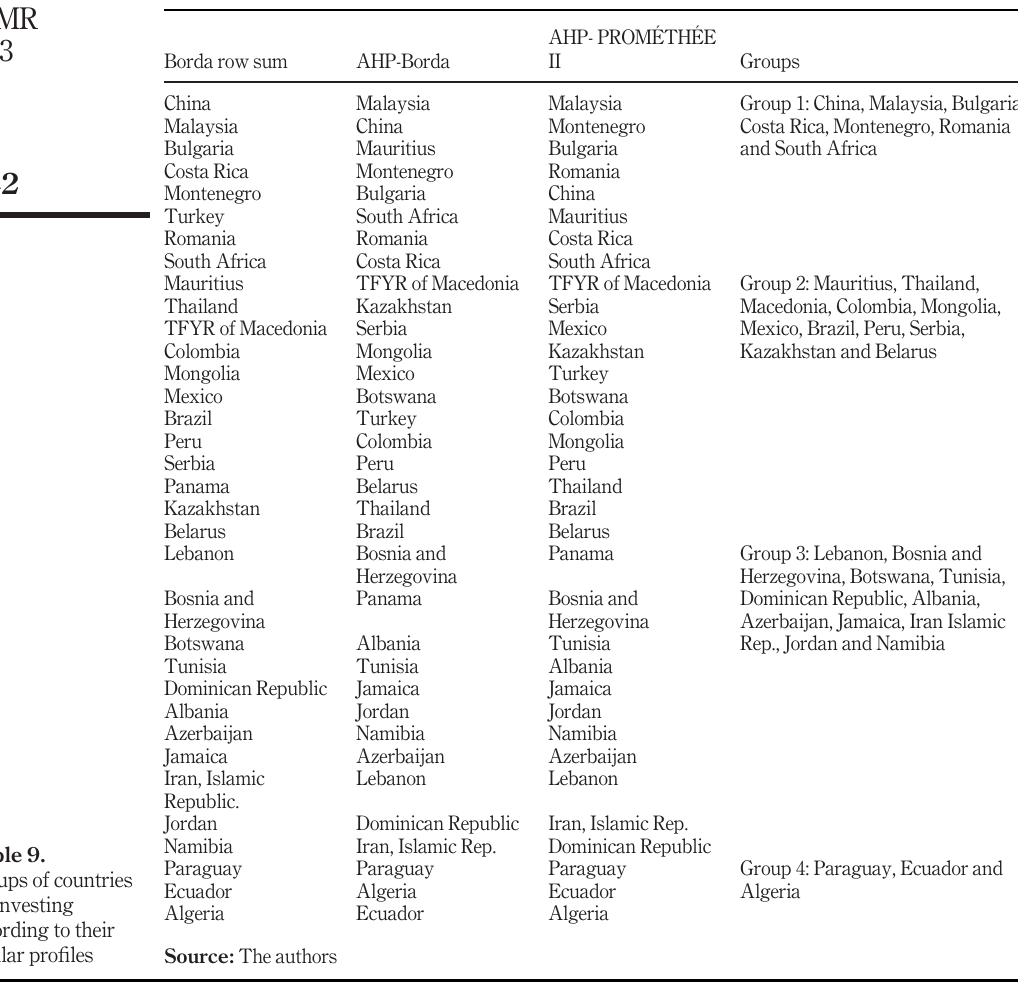
Table 9. Groups of countries for investing according to their similar pro fi